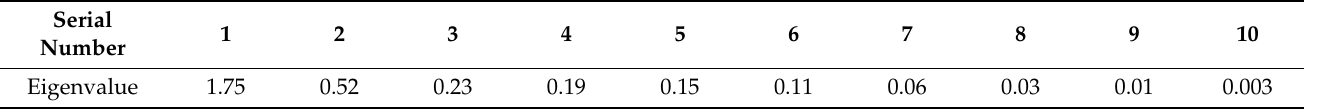
Table 9. Ten largest